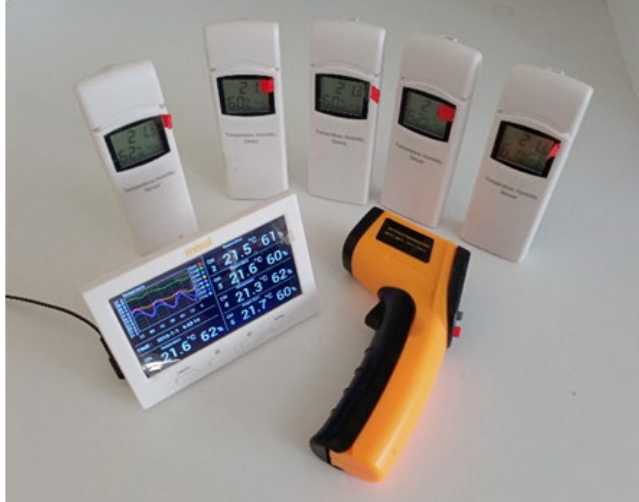
Table 4. Instrumentation range and accuracy.